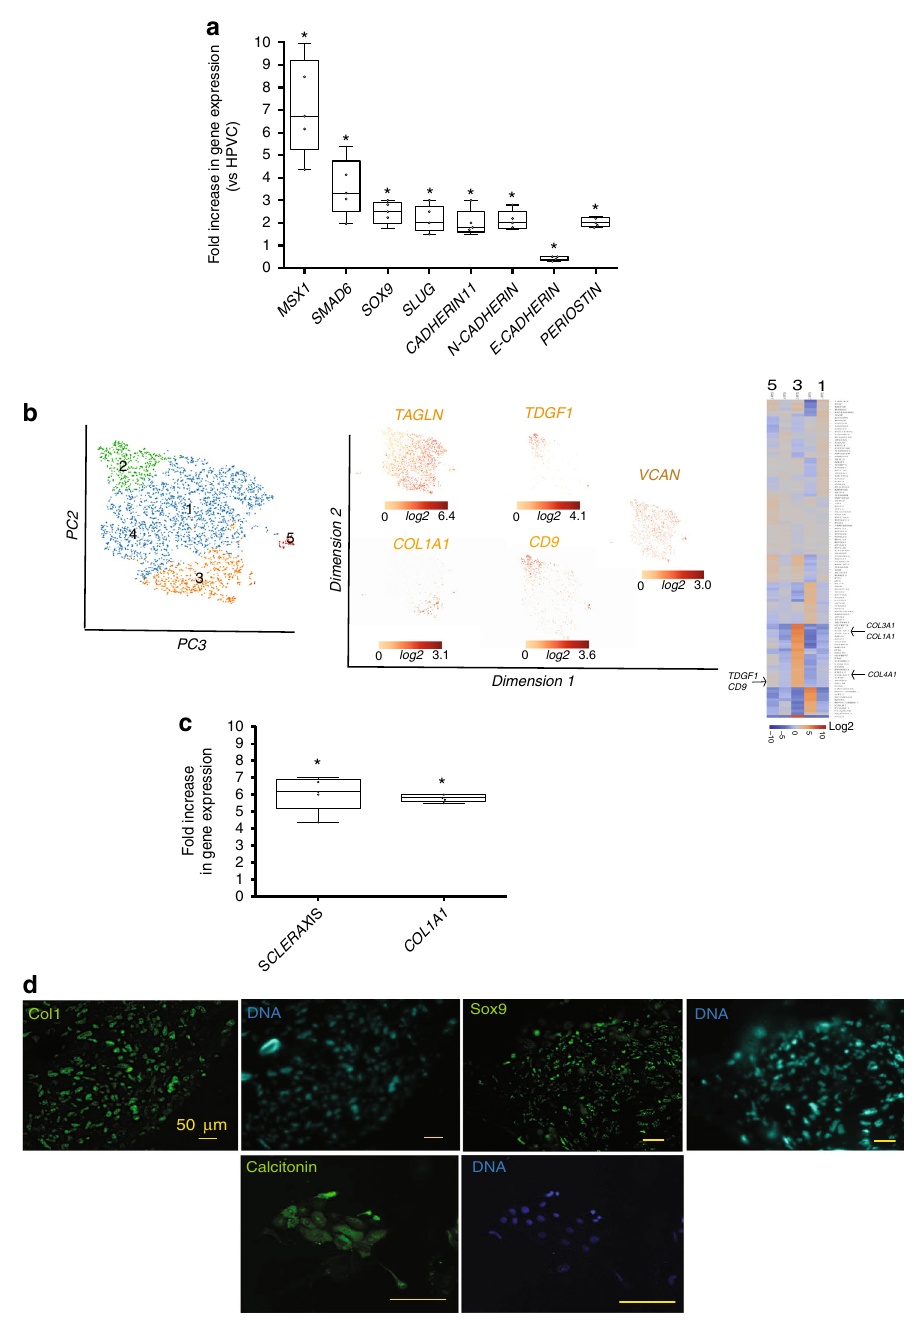
Fig. 2 EMT of HPVC cells. a After 6 days of FGF8/FGF2/VEGF treatment on MEFs, valve progenitors (HPVCs) were recovered with trypsin, seeded on fi bronectin-coated wells and treated with 100 ng/ml BMP2. After 2 days, RNA was recovered and cDNAs were run in real-time PCR for post EMT markers. BMP2 samples are normalized on control (before treatment) samples, showing an increase in the expression of post-EMT markers Data are representative of 5 cell differentiation and EMT- induction experiments.Boxes and whiskers (min to max) show the values lower than the 2.5th percentile and greater than the 97.5th percentile as circles. (*) signi fi cantly different p ≤ 0.01. b t-distributed stochastic neighbor embedding (t-SNE) 2D cell map 10X genomics ( n = 3700) cells (left panel). Highlight of cell populations expressing TAGLN and genes marking more speci fi cally fi brosa ( COL1A1 ) or spongiosa ( CD9, TDGF1 ) (middle panel) and heatmap of graph-based Log2 fold changes in gene expression of cell cluster compared to all other cells (right panel). c HPVCs give rise to tendinous/chondrogenic cells. HPVCs were pelleted into a tube and treated with a chondrogenic medium as described in the methods. Real-Time PCR shows an upregulation of Scleraxis and Collagen 1a ( Col 1 ) genes versus non-treated cells following three weeks of treatment (two experiments in duplicate; (*) signi fi cantly different p ≤ 0.01). d The cell pellets were embedded in paraf fi n and 5 um sections stained with anti Sox9, anti-Collagen1a and anti- calcitonin antibodies. Data are representative of 3 experiments. The scale bar indicates 50 μ m. Source data are provided as a Source Data fi